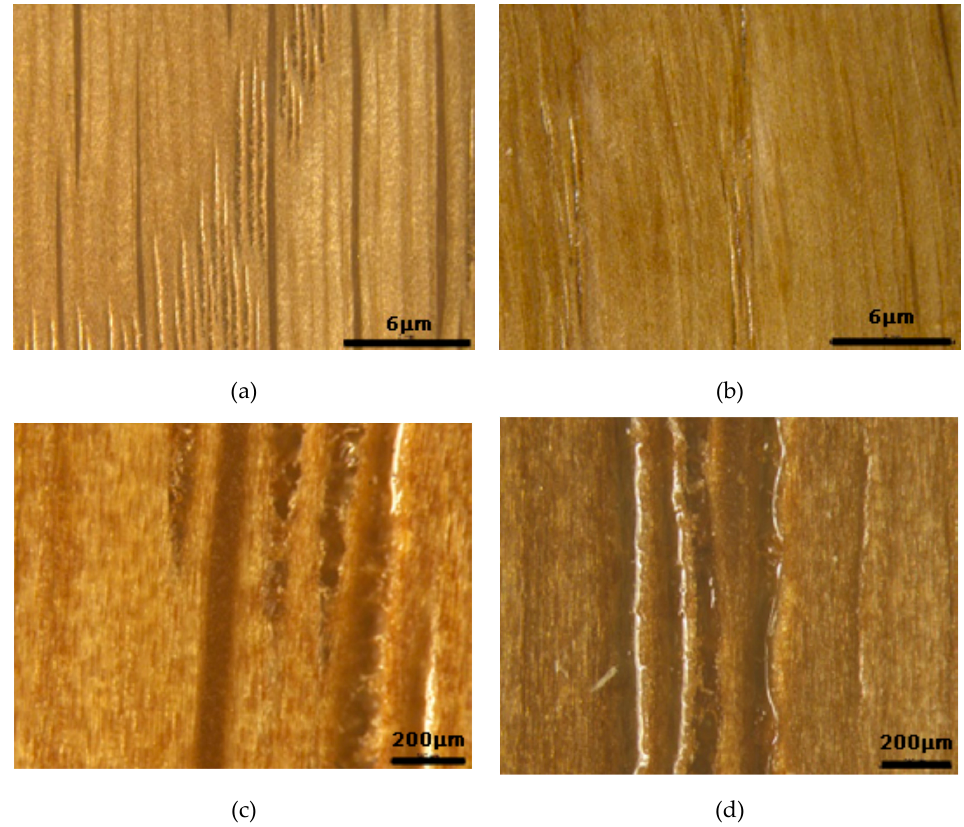
Figure 3. Optical microscope images of oak after coating at different coating amounts. (a,c) 12 g/m 2 PUA coated oak; (b,d) 60 g/m 2 PUA coated oak. Polymers 2019 , 11 , x FOR PEER REVIEW